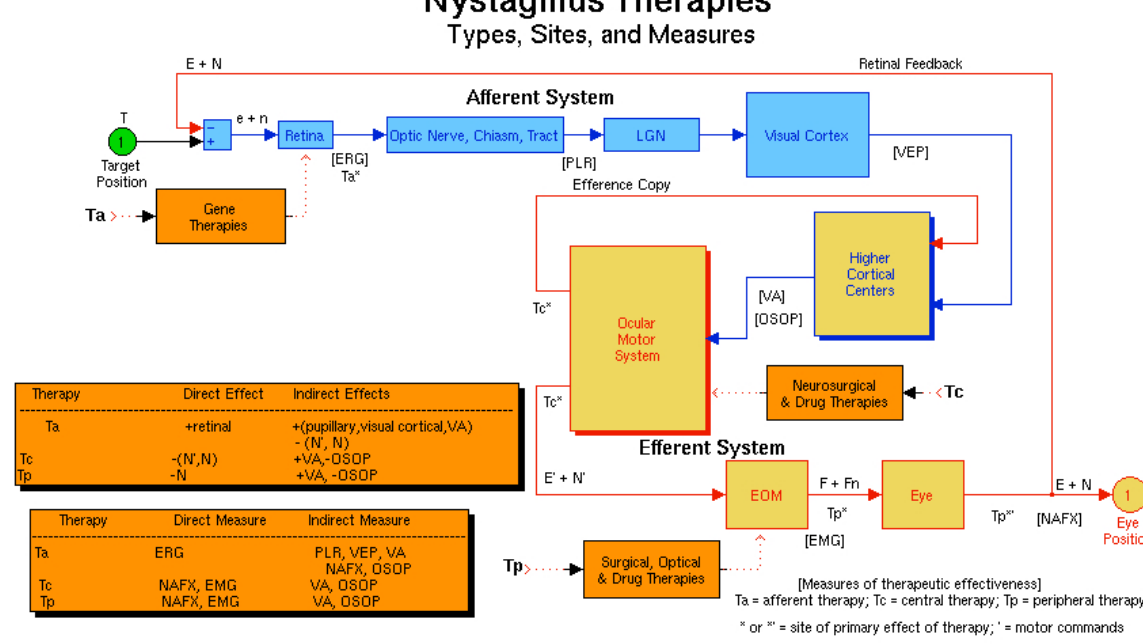
FIGURE 4. A block diagram of the ocular motor system indicating the types of therapeutic intervention for nystagmus, their anatomic sites, and direct and indirect measurements of their effectiveness. Ta is afferent therapy for deficits in the visual system (shown here is gene therapy for retinal deficiencies), Tc is central (neurosurgical or drug) therapy for nystagmus, and Tp is peripheral (surgical, optical, or drug) therapy for nystagmus. Shown in square brackets are the sites of therapeutic tests of visual and ocular motor function. The direct and indirect effects of each type of therapy and the direct and indirect outcome measures for each are listed in the Legend Boxes. e = retinal error; n = nystagmus error; E = eye position; N = nystagmus; F = extraocular muscle force; Fn = extraocular muscle nystagmus force; ERG = electroretinogram; PLR = pupillary light reflex; VEP = visual evoked potential; EMG = electromyogram; NAFX = expanded nystagmus acuity function; + = improved, higher, or better; – = diminished, lower, or less; blue/light-blue blocks = afferent sensory; blue/yellow block = afferent-efferent sensorimotor; red/yellow blocks = efferent motor; and black/orange blocks =